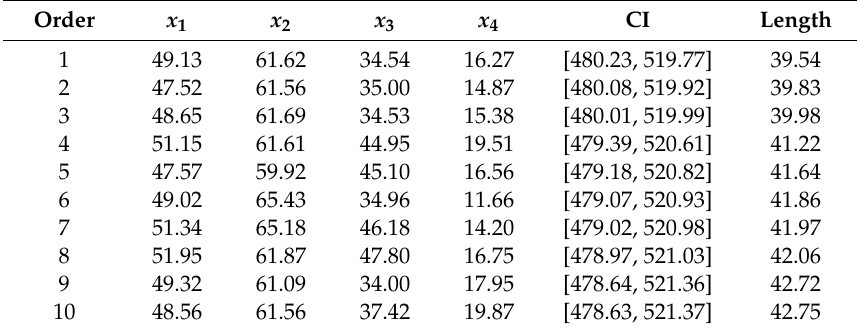
Table 6. ( y target = 500) Results of finding L’ = 10 solutions using the proposed method.